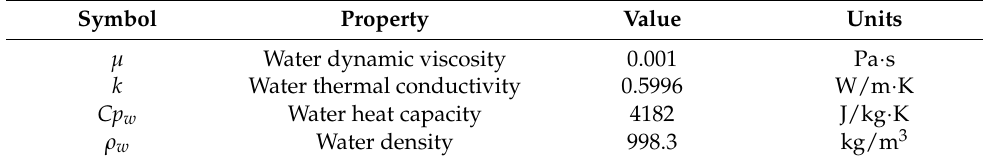
Table 3. Physical values of water at 20 ◦